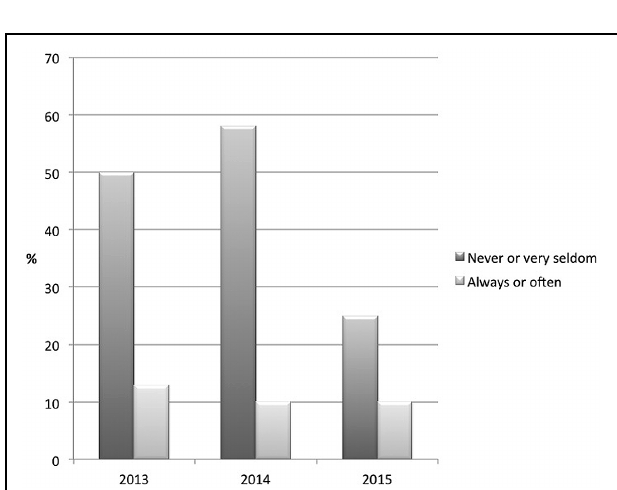
FIGURE 1 | Polarization of attitudes toward hen was reversed from 2012 to 2015. ‘Negative attitudes’ = 1 and 2 on the rating scale; ‘positive attitudes’ = 6 and 7 on the rating scale.